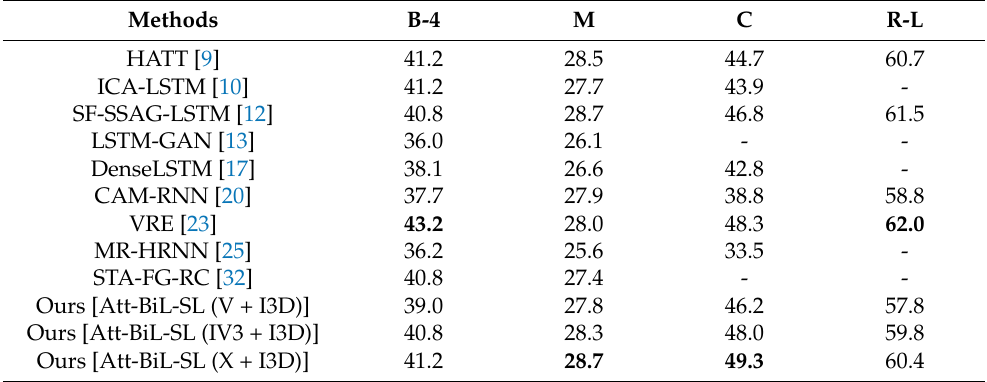
Table 3. Evaluation results of our method and previous methods for the video description generation on the MSR-VTT dataset. Here, “-” indicates the metric is not considered. All the numerical terms are in percentile format. Texts with bold marks are the best